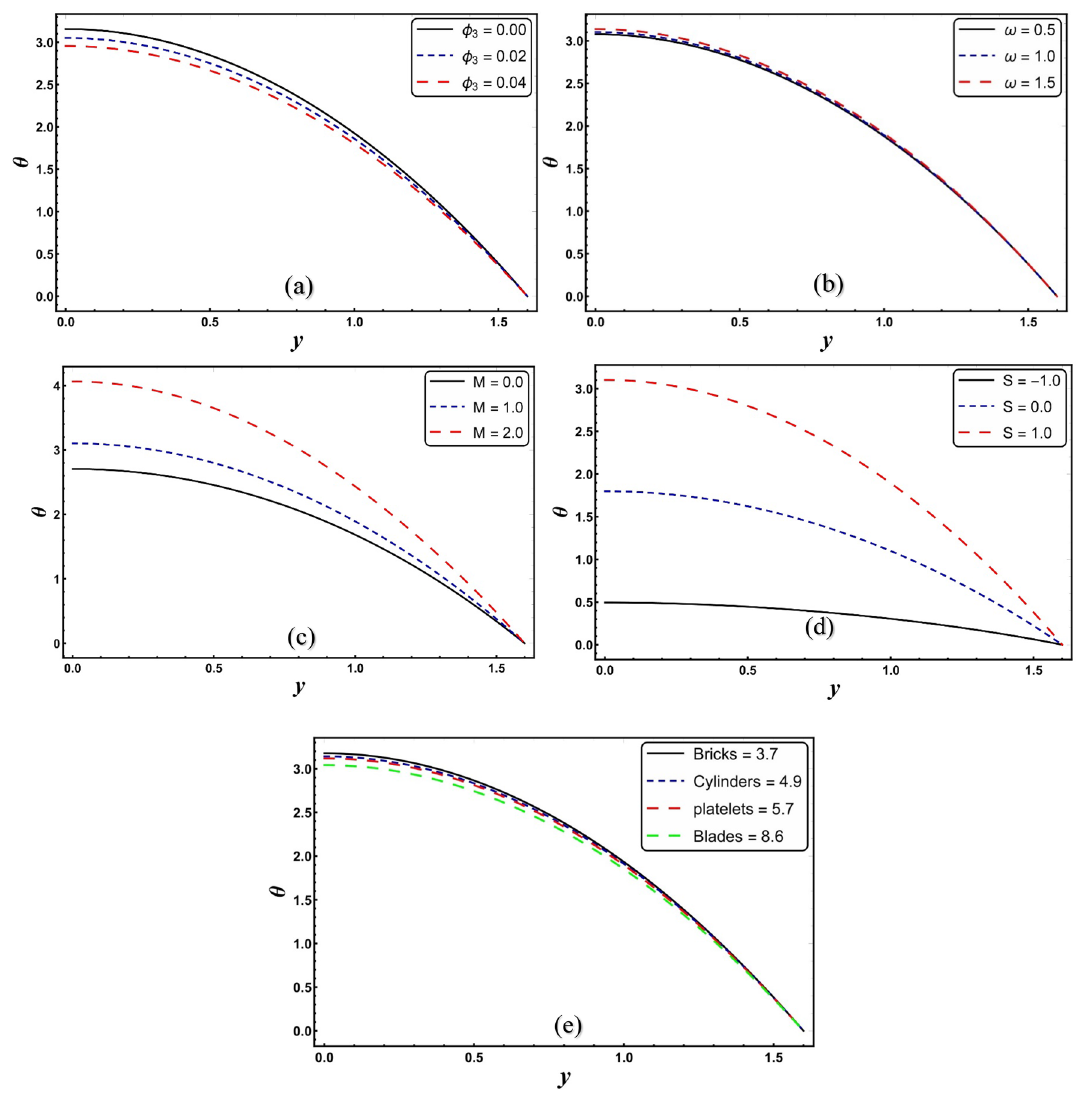
Figure 4. ( a – e ) θ for change in various